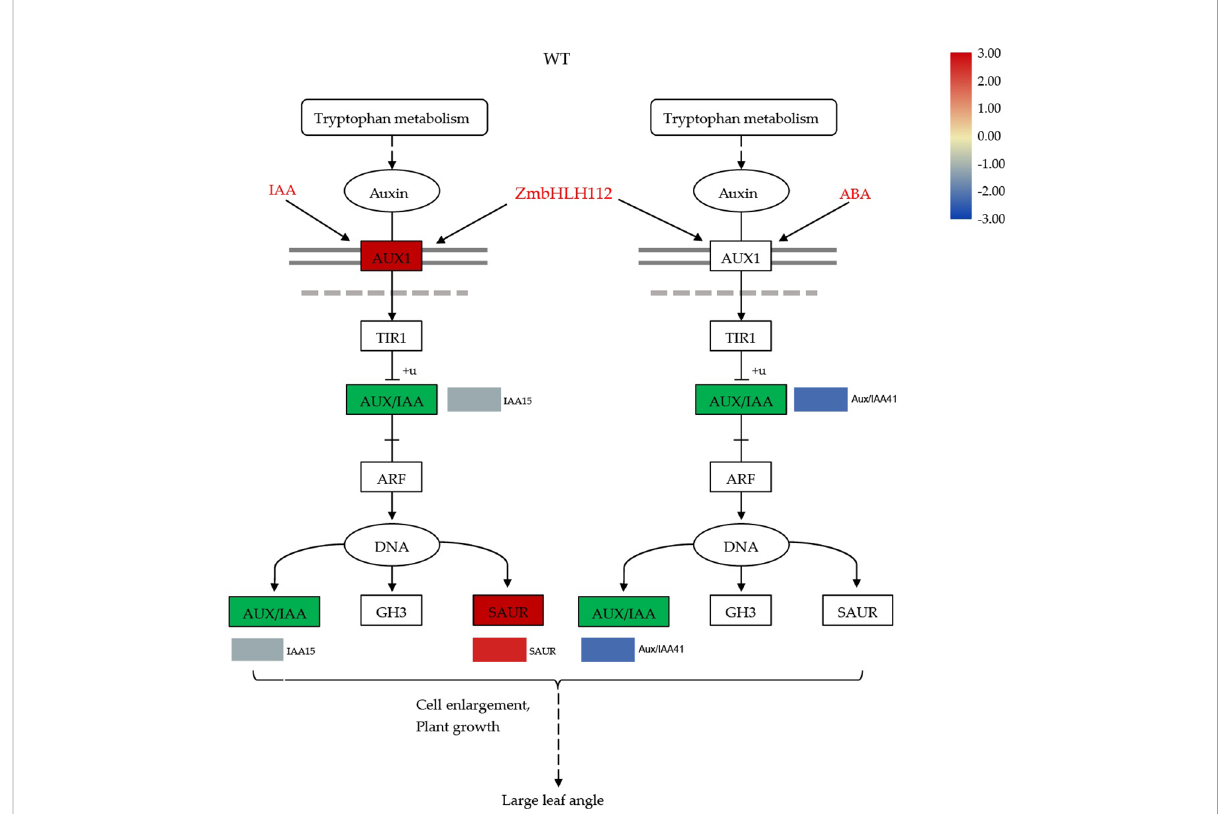
FIGURE 11 Molecular model for the regulation of maize leaf angle development by ZmbHLH112 . ZmbHLH112 mediates the auxin signaling pathway. WT: wild-type